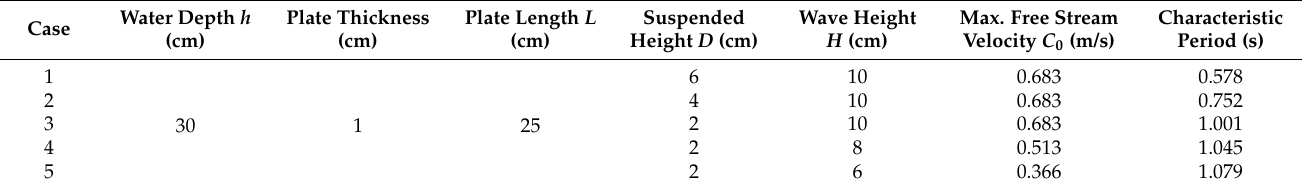
Table 1. Experimental